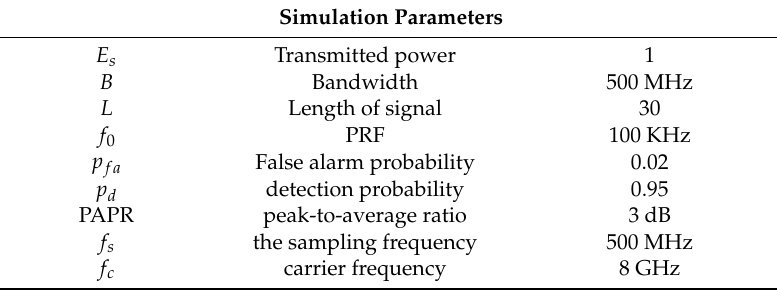
Table 1. Simulation